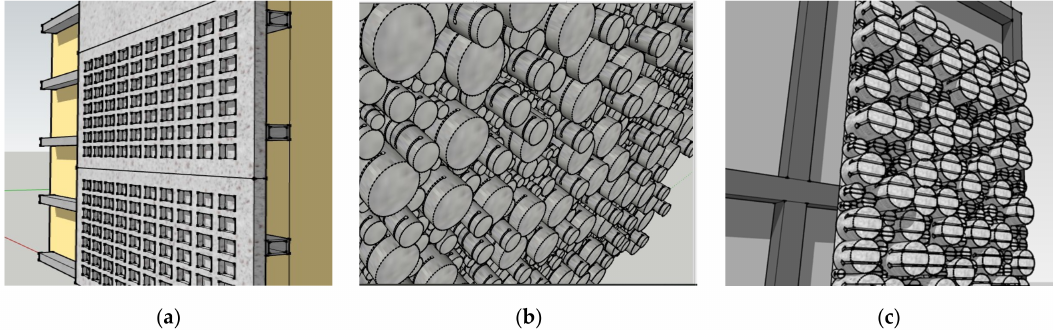
Figure 14. The seashell composites in various patterns: waffle ( a ); Side-tailed cavity pattern ( b ); and front-tailed cavity pattern ( c ).